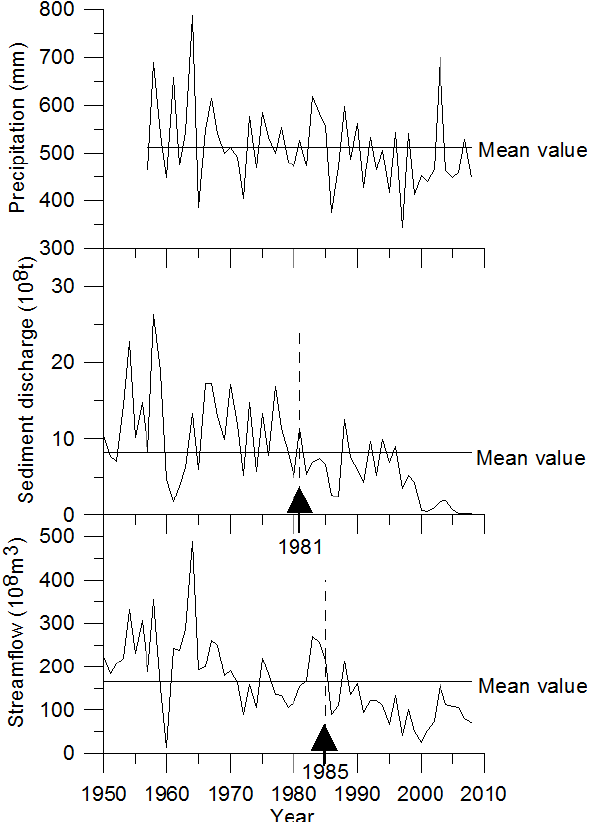
Fig. 2. Observed annual precipitation, streamflow and sediment dis- charge during 1950–2008 in the MRYR basin. The black arrow is change-point year.